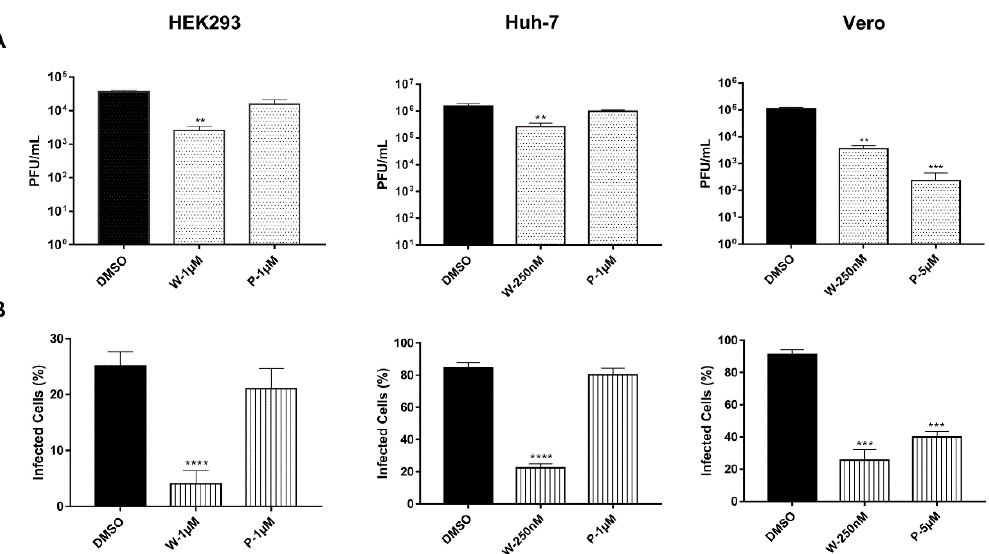
Figure 2. Inhibition of deubiquitinating enzymes impairs chikungunya virus replication. Cells were pre-treated with the indicated concentrations of WP1130 (W), PR-619 (P), or DMSO for 1 h. After that, cells were infected with CHIKV for 1 h, the inoculum was then removed and replaced with fresh media supplemented with inhibitors. After 24 h of infection, supernatants and cells were collected. ( A ) Released viral progeny was measured using the plaque assay method. ( B ) Infected cells were analyzed using flow cytometry. Data are represented as the mean + SD, and statistically significant differences are indicated as ** p < 0.01, *** p < 0.001, **** p < 0.0001.